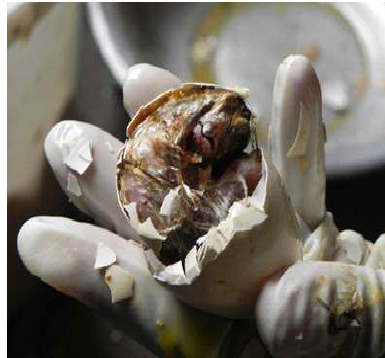
Figure-2. Photograph showing dehydrated dead-in-shell